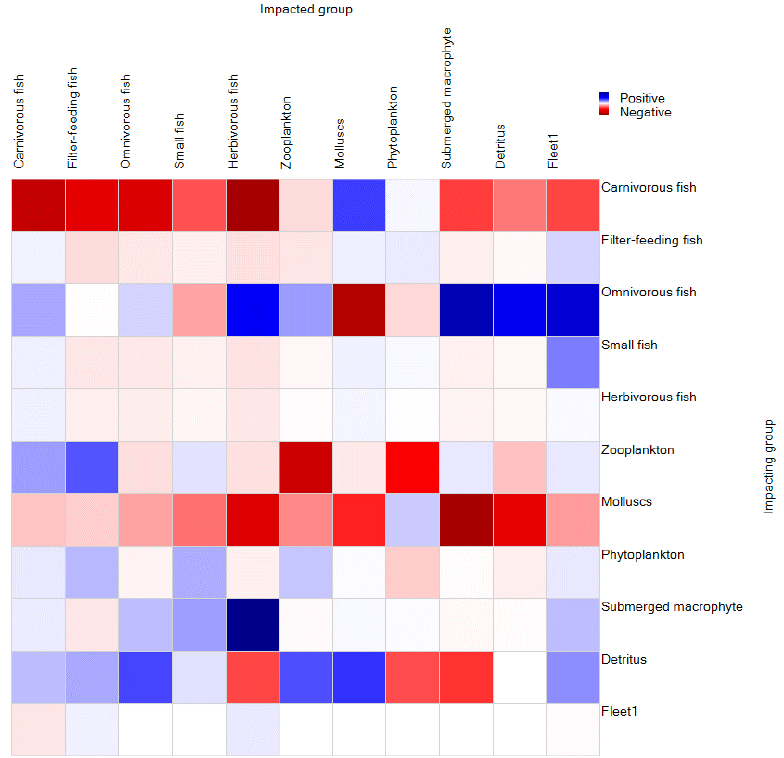
Figure 4. Mixed trophic impacts among the functional groups of the Lake Datong food web.